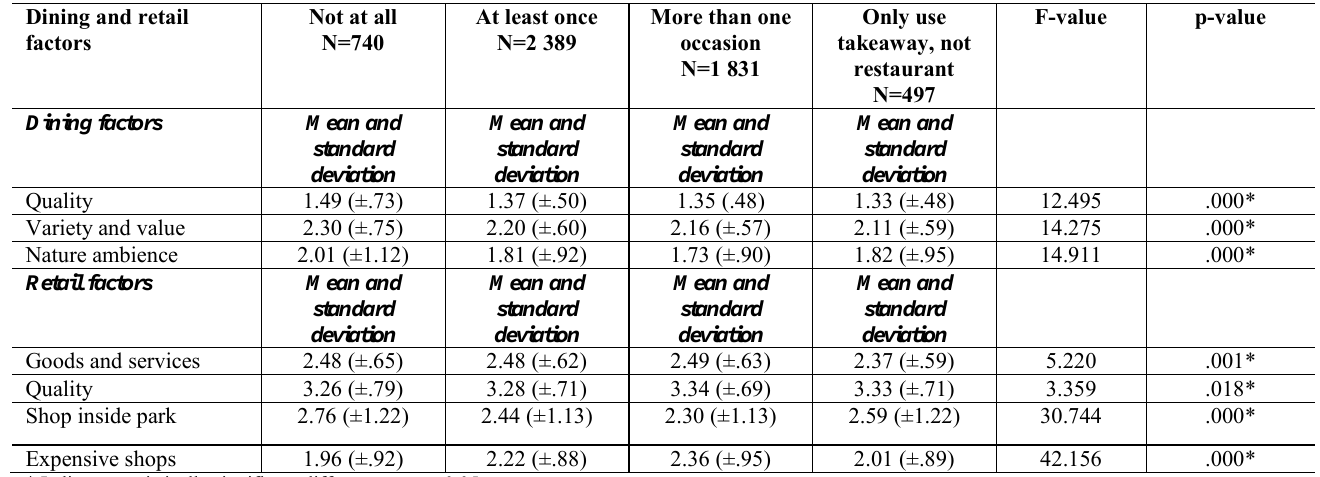
Table 5: ANOVA for comparison of restaurants and shop factors by restaurant use Dining and